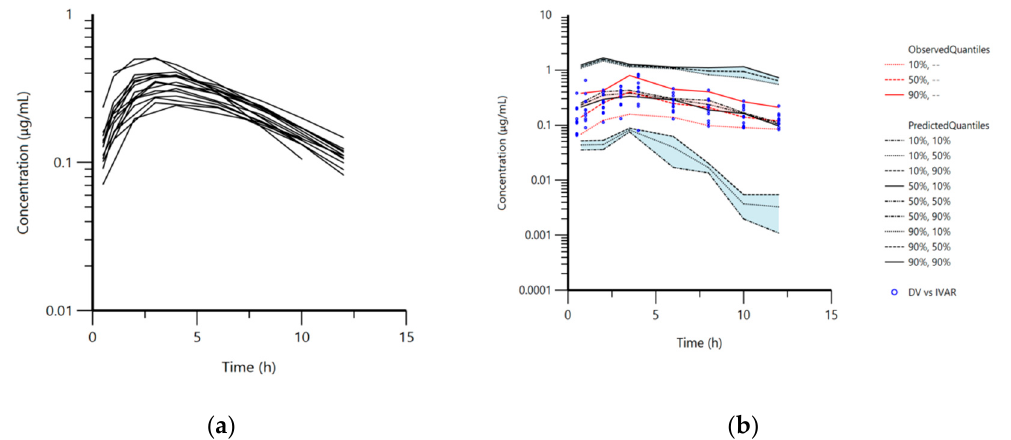
Figure 1. ( a ) Semi-logarithmic spaghetti plot of disposition curves of orally administered doxycycline hyclate in rabbits ( n = 16) at a dose rate of 5 mg/kg and ( b ) visual predictive check (VPC) plot depicting the observed quantiles (10, 50, and 90%) and corresponding predictive quantiles. Light pink and light blue areas correspond to the 95% confidence interval of the three predicted quantiles.